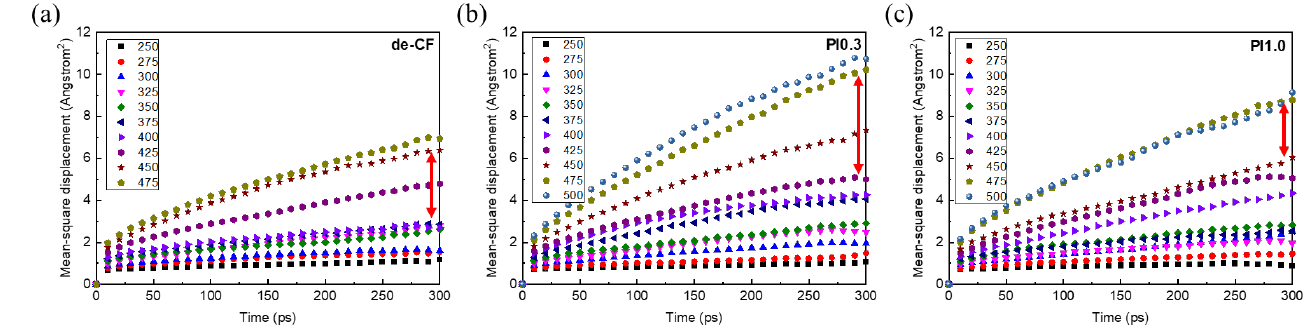
Figure 13. Mean square displacement (MSD) results: ( a ) de-CFs, ( b ) PI0.3, and ( c ) PI1.0.